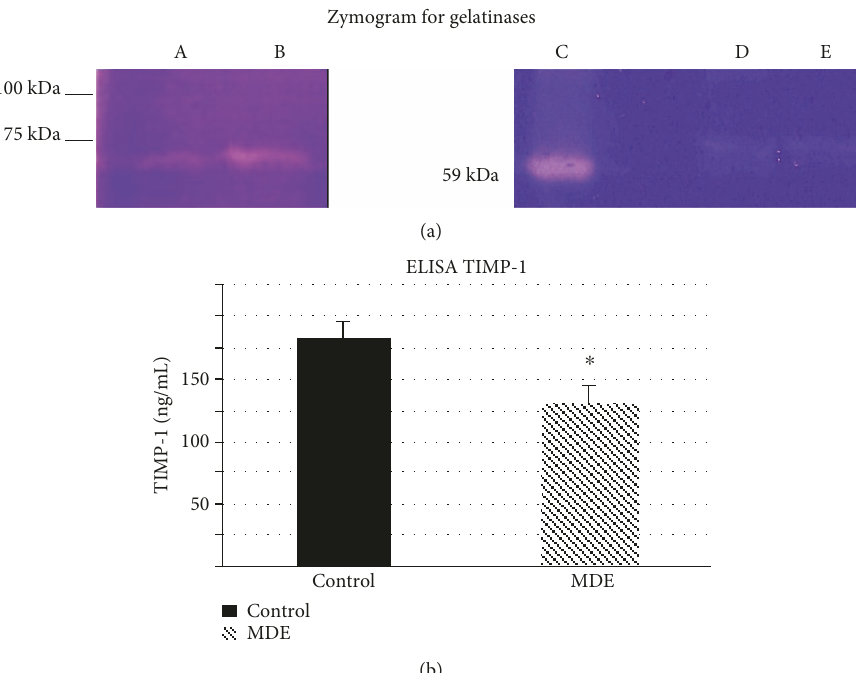
Figure 2: (a) Representative zymogram for gelatinases. (A) supernatant of fi broblast culture from a control subject; (B) supernatant of fi broblast culture from a MDE patient; (C) active form of human MMP-2 (59 kDa form), (D) and (E) are the same samples of (A) and (B), respectively. (b) Quantitative determination of TIMP-1 by ELISA. The values are mean ± SD of triplicate determinations on supernatants from three fi broblast cultures of MDE patients and three controls. ∗ p < 0 05 versus control